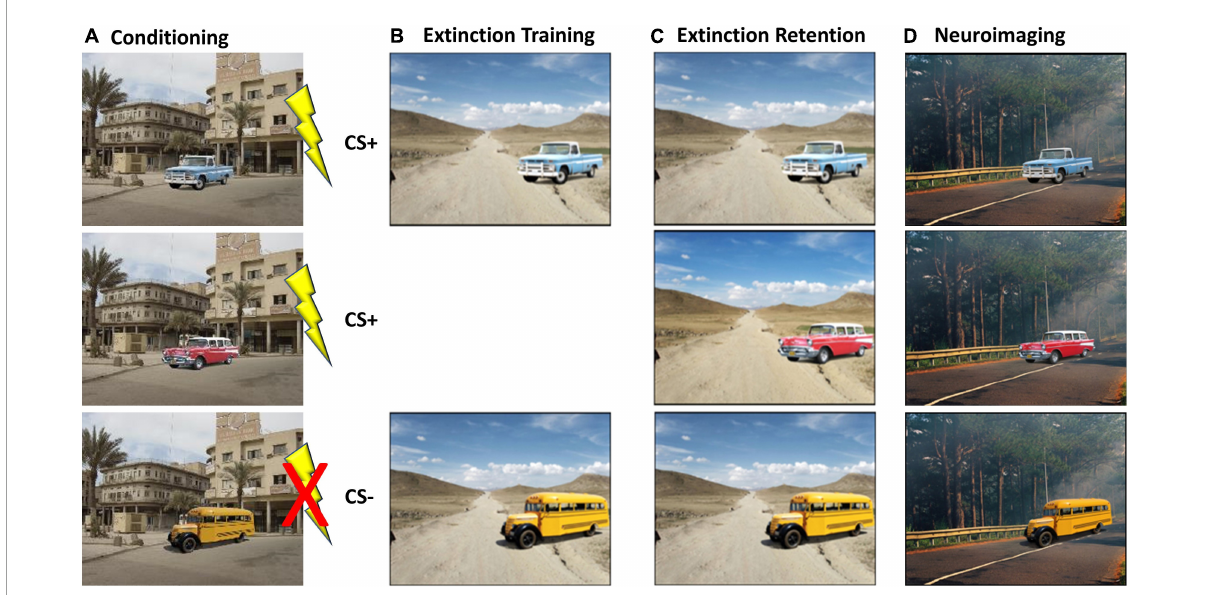
FIGURE3 Overview of the modified fear-conditioning/fear-extinction protocol. (A) At baseline, participants were conditioned to fear two of three stimuli (i.e., blue truck and red car) by a mild but not painful electric shock (Pace-Schott et al., 2009), and skin conductance was measured. (B) On the same day, participants underwent extinction of the blue truck, but not the red car. Extinction was demonstrated by a reduction in skin conductance. (C) After 6 weeks of morning light treatment (blue or amber), participants returned to the lab and were shown the same stimuli again and skin conductance was measured. (D) Participants were shown the same stimuli, in a different visual context, while undergoing functional magnetic resonance imaging (fMRI).